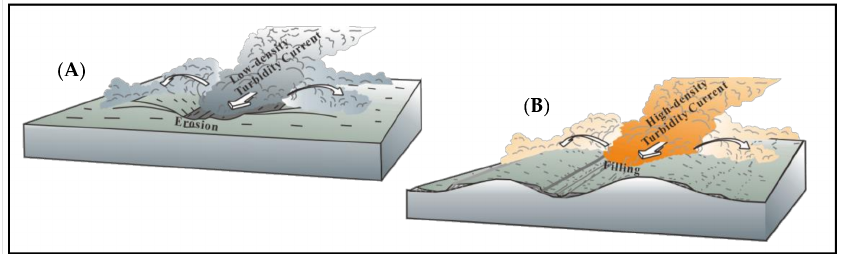
Figure 14. Transformation of basin floor by turbidity currents (modified after Shanmugam et al., 1993 [55]). ( A ) Low-density turbidity currents eroded the basin floor. ( B ) Turbidite channel filled with deposits of high-density turbidity